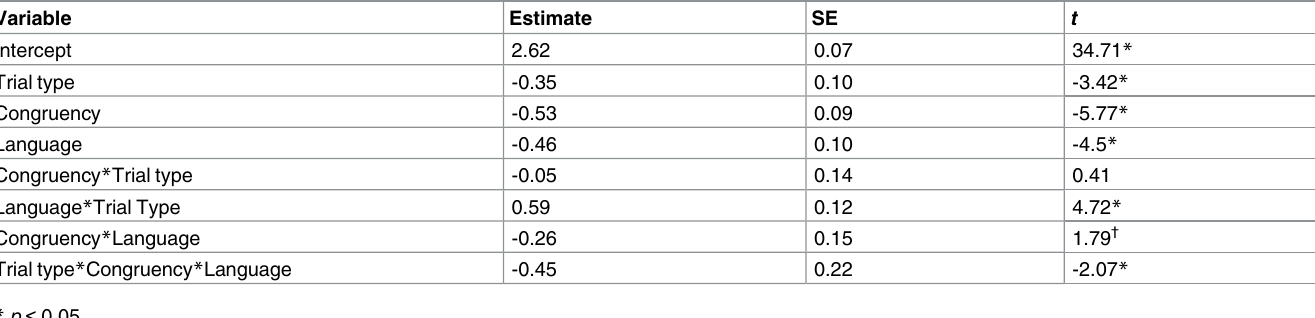
Table 7. Results of mixed-effects modelling on language choice (Experiment